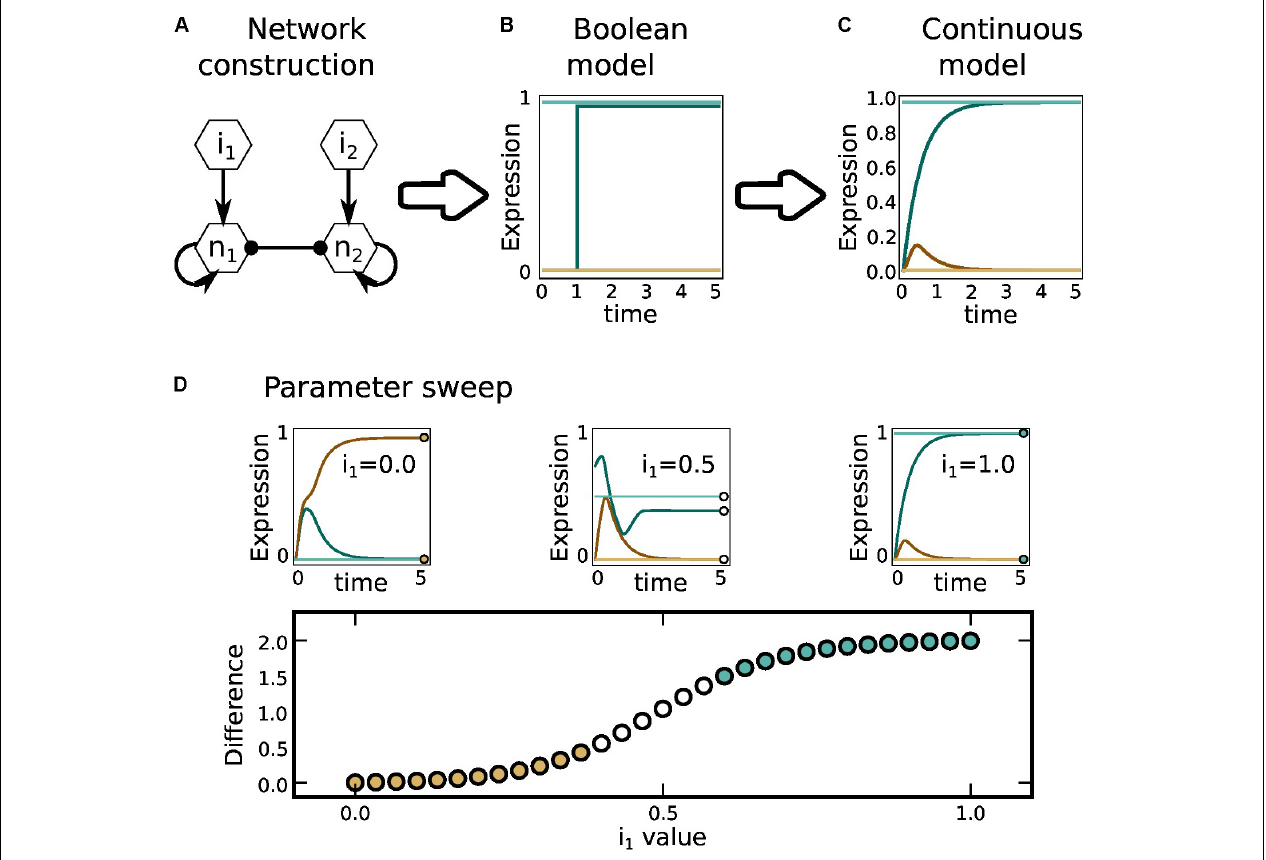
FIGURE 1 | Methodology. Using available experimental data we constructed (A) the regulatory network, (B) Boolean functions (Martinez-Sanchez et al., 2015), and (C) ordinary differential equations (current article). (D) We then determined the resulting steady state for different concentrations and exogenous cytokines.